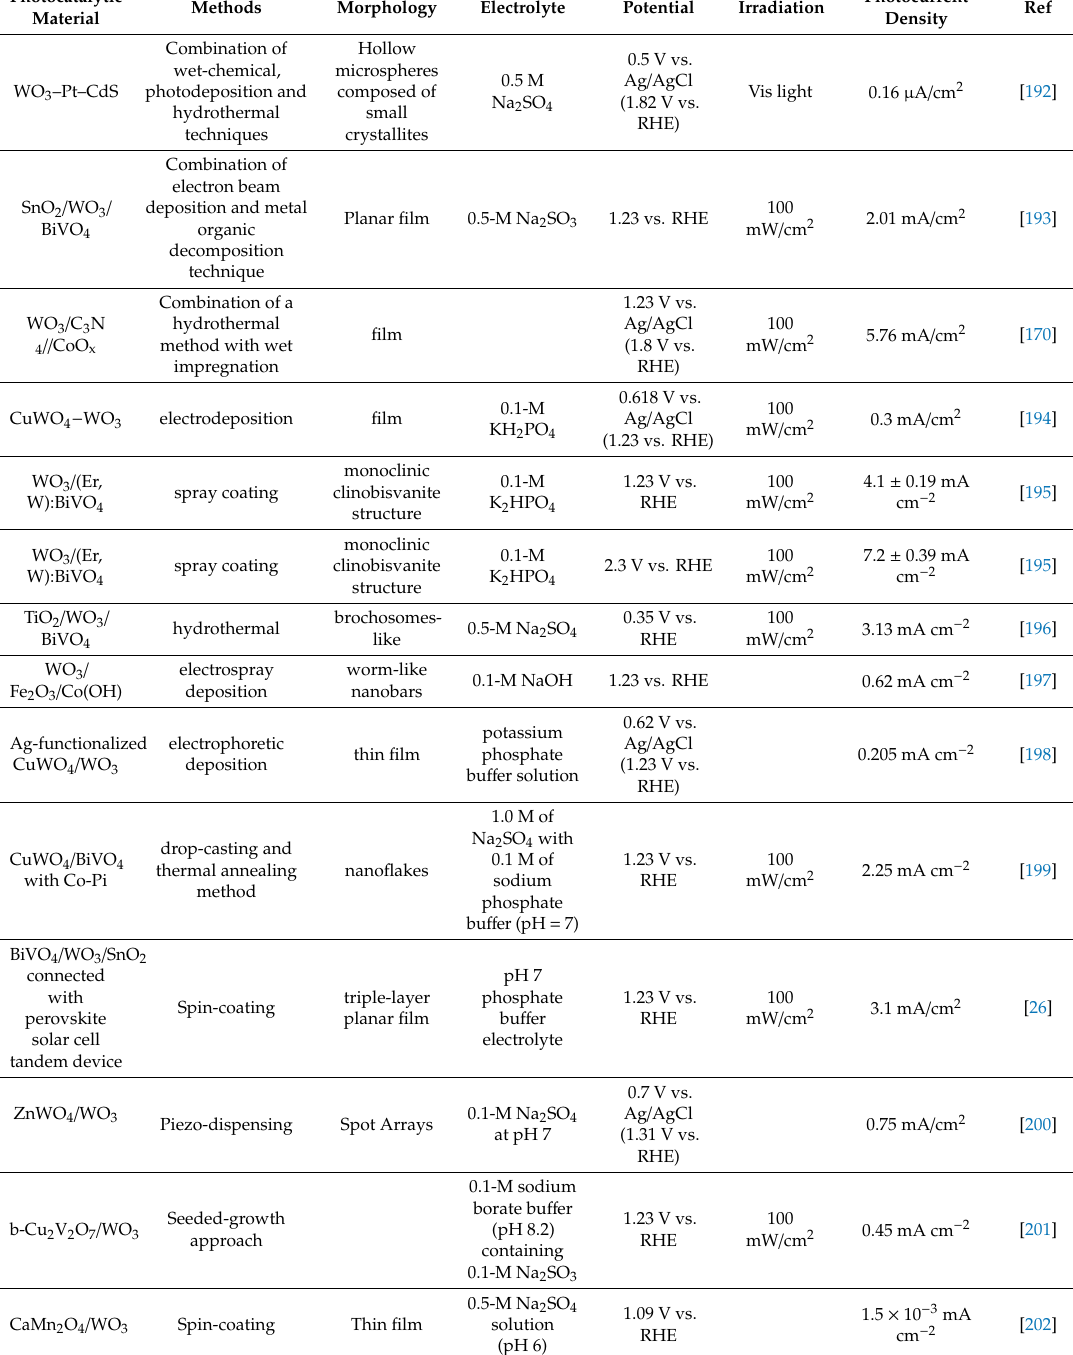
Table 2. Photocurrent densities of ternary